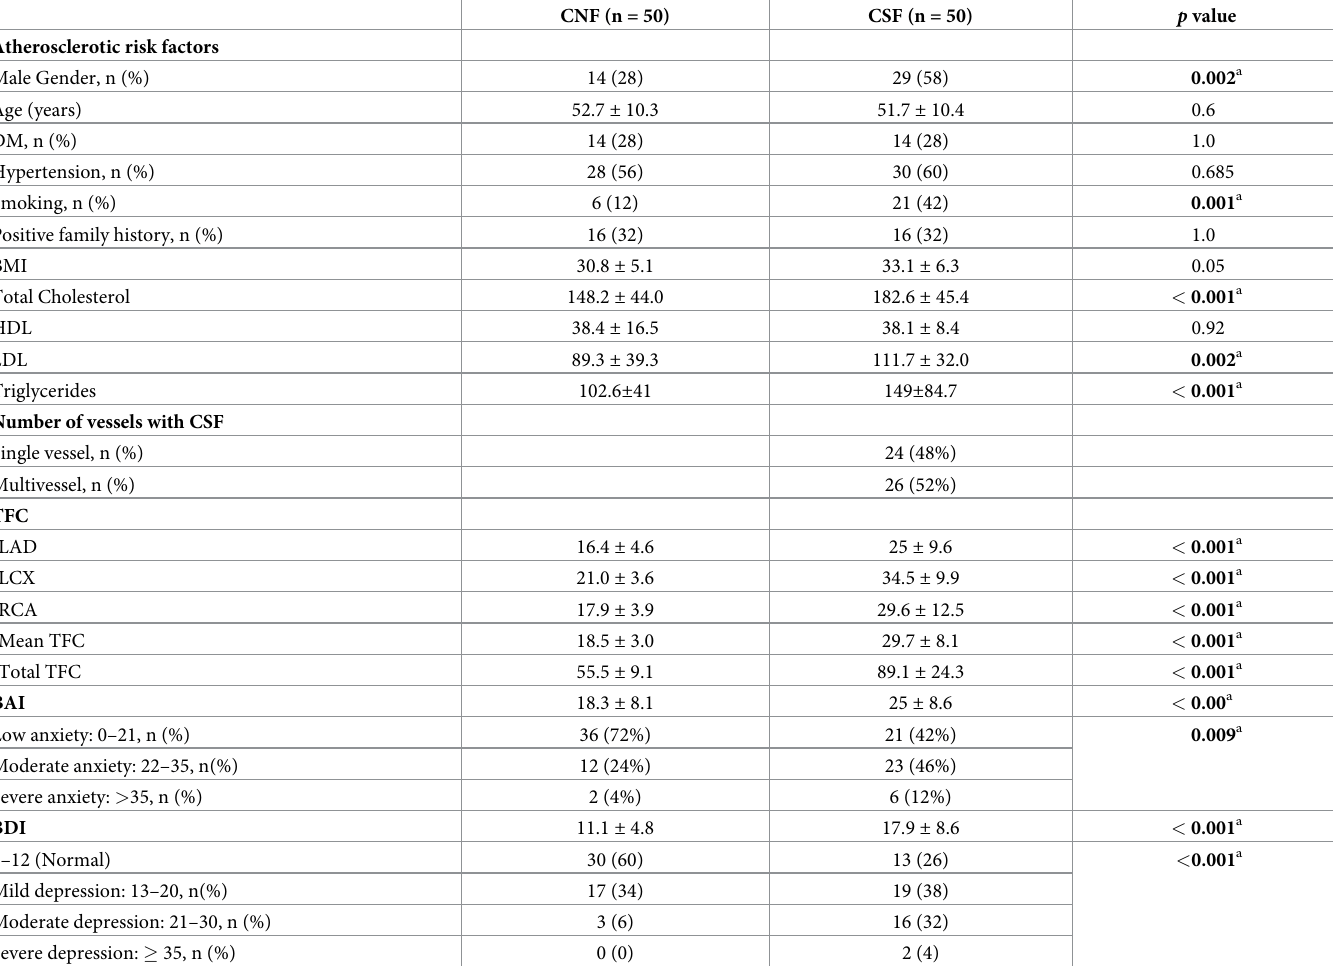
Table 1. Demographic data, risk factors, coronary angiography results and psychiatric test results in study